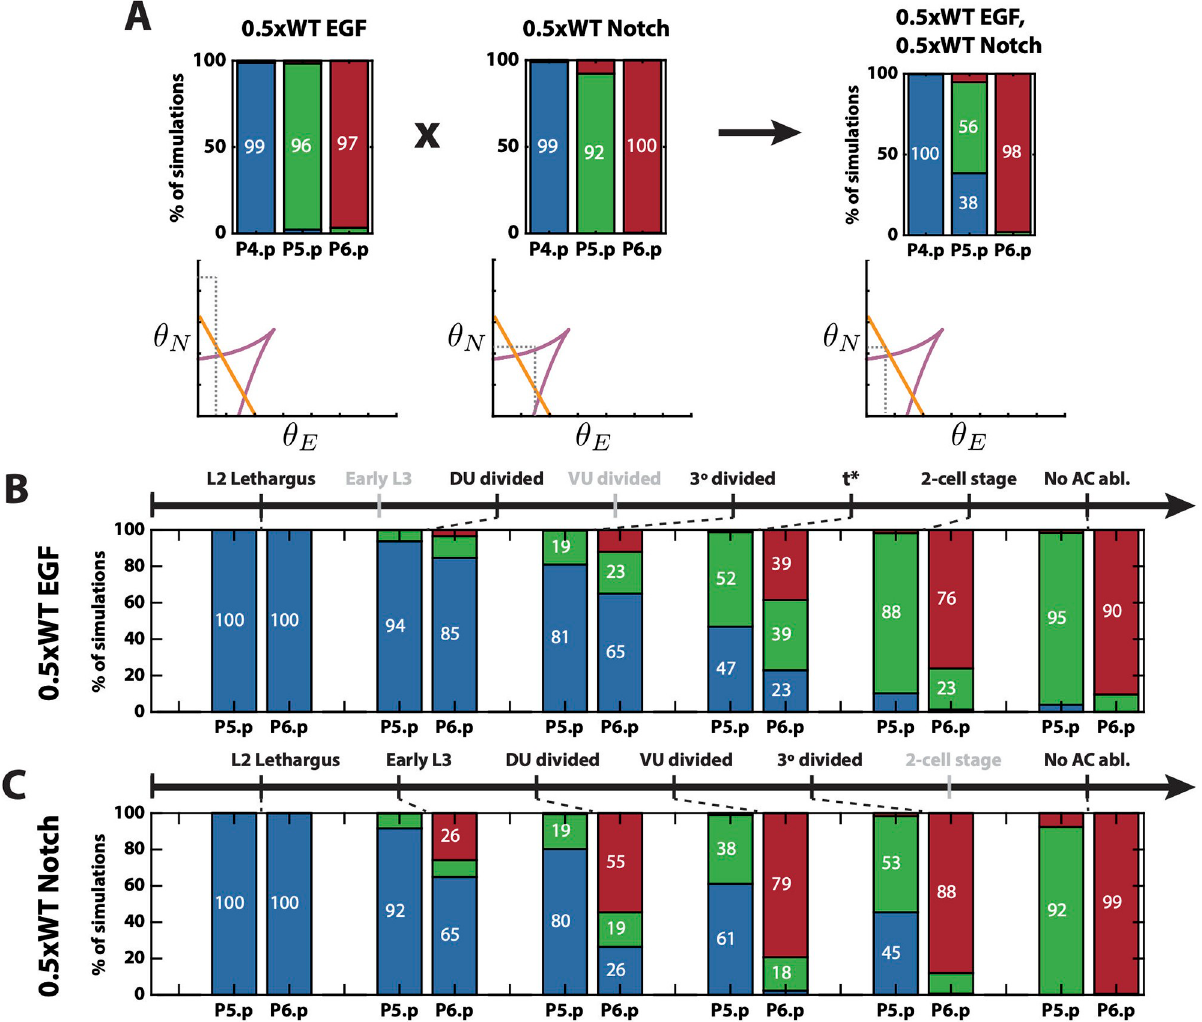
Fig 7. Model’s predictions. (A) Predicted epistasis under the cross of reduced EGF ligand and Notch receptors perturbations. Top: Simulated proportions under the corresponding signaling profiles. Bottom: Schematics of the simulated positions of P5.p in the signal space under the different signaling profiles. (B) Predicted pattern proportions for different AC ablation times under a reduced EGF ligand perturbation. t � is a predicted time between 3˚ divided and 2-cell stages. The stages for which simulations are not shown are colored in gray. (C) Predicted pattern proportions for different AC ablation times under a reduced Notch receptors perturbation. The names of the stages for which simulations are not shown are colored in gray.